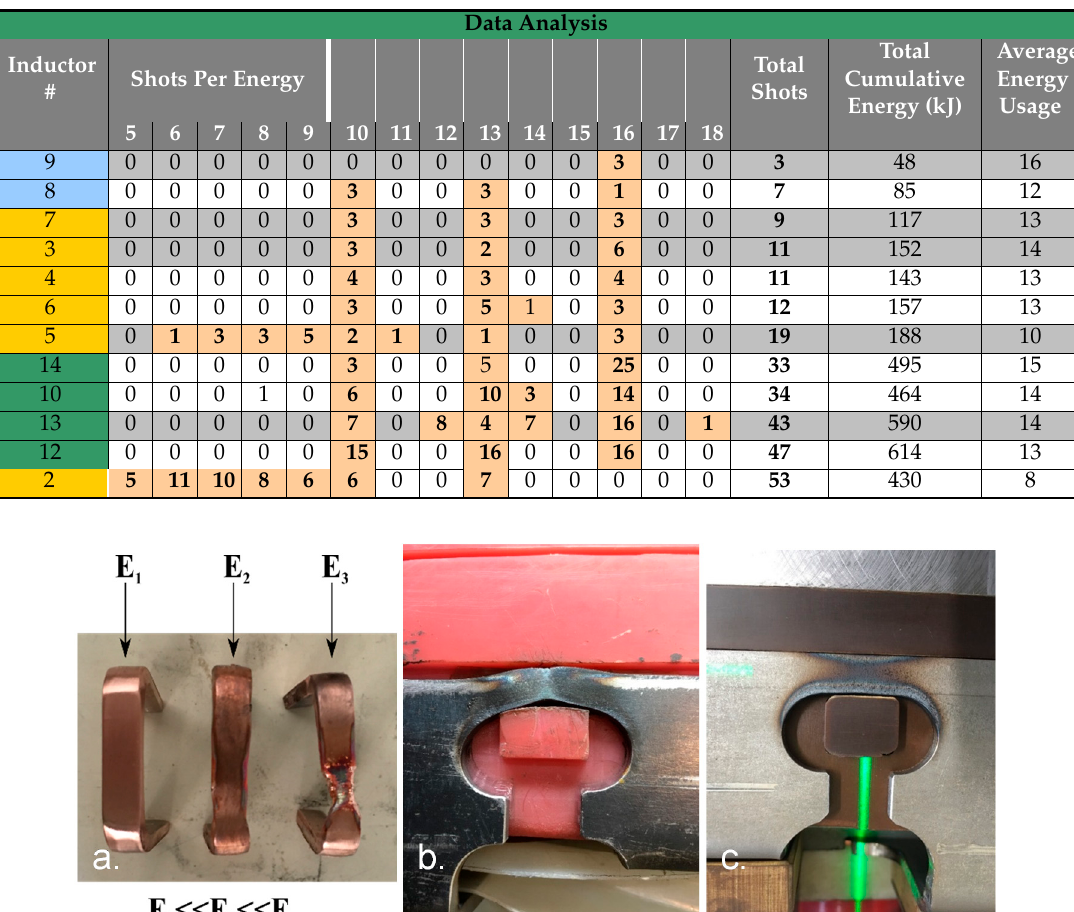
Table 14. Matrix of tests with di ff erent inductors (in blue O-shape coil with polyurethane support, in yellow linear coil and in a green O-shape coil with fiberglass / epoxy resin composite support).